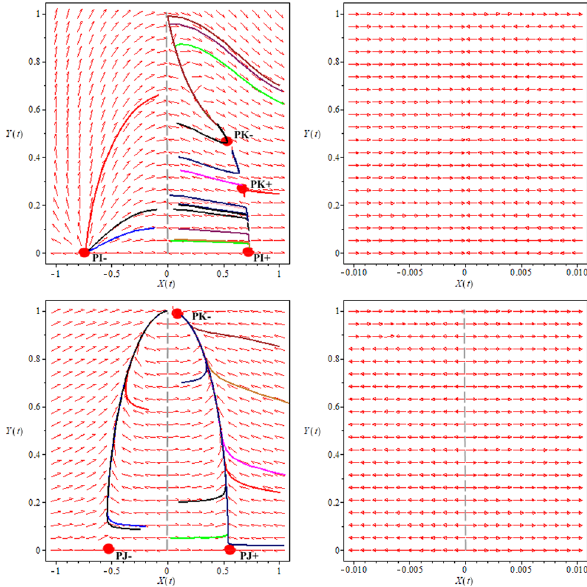
Fig. 9 Phase portrait of the autonomous system of ordinary differ- ential equations (21) and (22) for the case α = − β and the specific choice (β = 2 ,λ = 2 . 5 ) —top panels— (β = 0 . 25 ,λ = 1 . 75 ) — bottom panels—. The gray line corresponds to the separatrix X = 0 which exists for Y (cid:2)= 1. It can be seen that the trajectories end at it for α/( 1 − α + β) < 0 or depart from it if α/( 1 − α + β) > 0. The behavior of the trajectories around the separatrix is shown in the right- hand side. In the upper scenario, Point I + and Point I − correspond to unstable nodes and Point K − denotes a saddle point. It is not relevant from cosmological considerations since there is no stable solutions. In the lower case, Point J + and Point J − behave as saddle and Point K − corresponds to an accelerated stable solution which can be the late time state of the